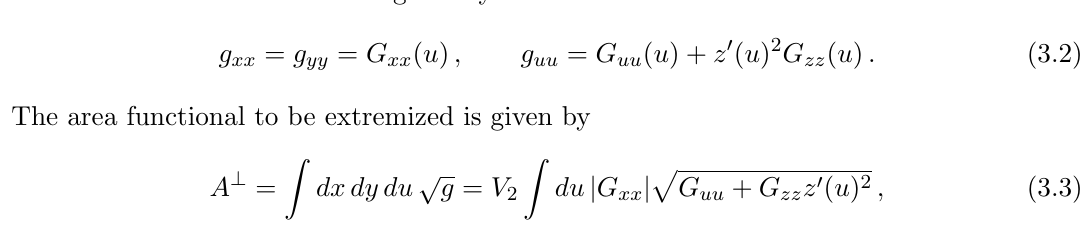
v ? 2 , while the dashed blue curve represents the result for 3 B 2 v iso 2 = 1, whereas the gray horizontal line is the result for a B 2 v Lif 2 = 33 B 2 32